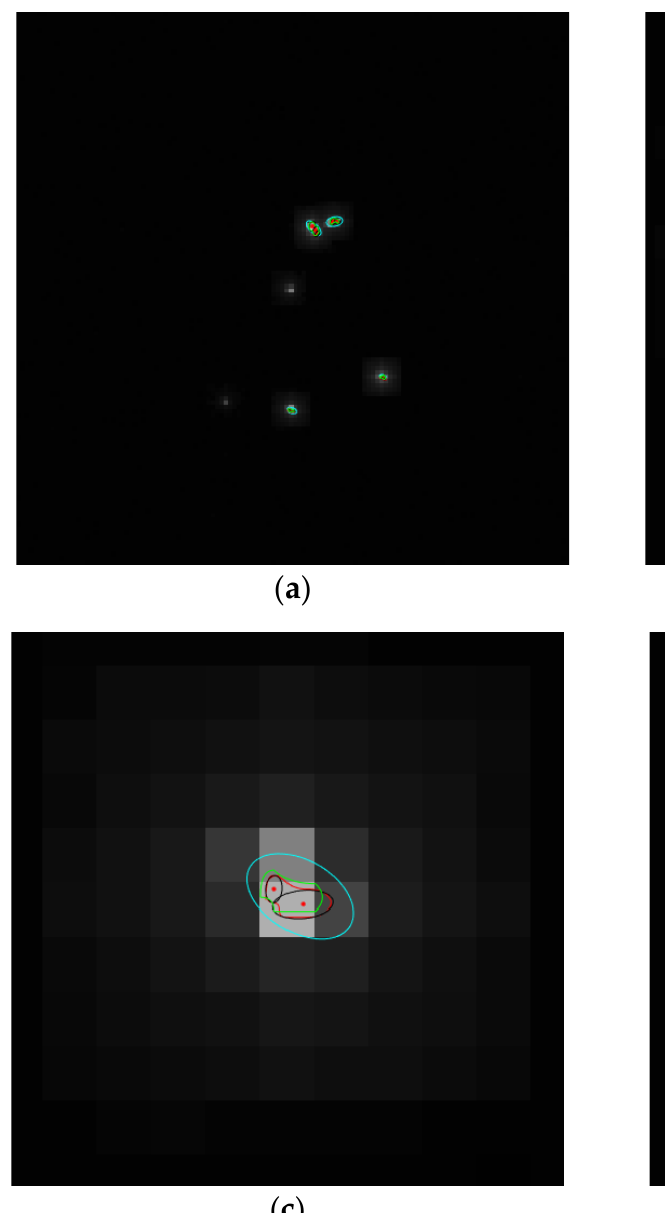
To demonstrate the effect of the measurement partition method on tracking perfor-